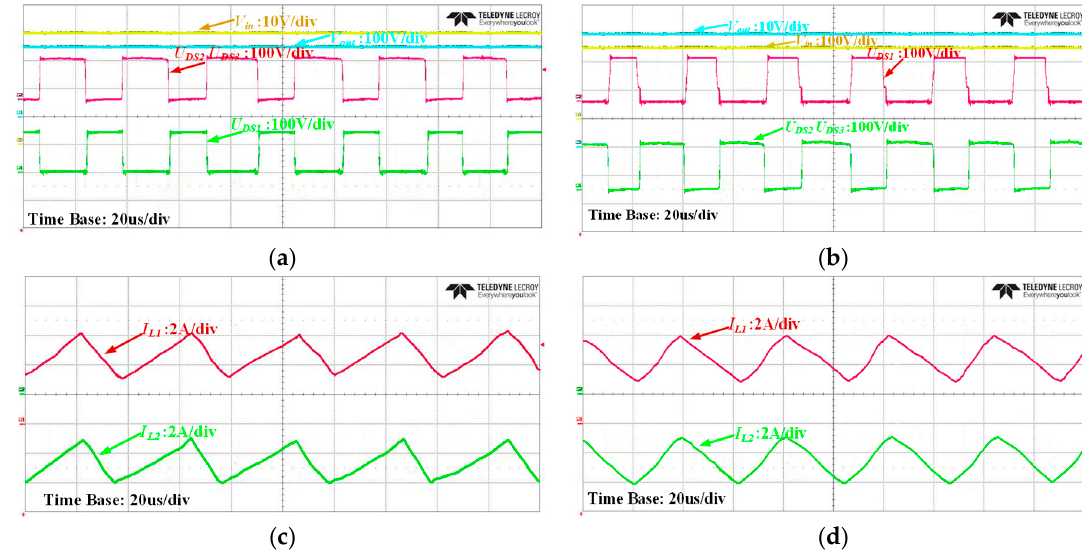
Figure 17. Experimental results: ( a ) voltage stress across Q 1 –Q 3 in boost mode, ( b ) voltage stress across Q 1 –Q3 in buck mode, ( c ) inductor current in boost mode, and ( d ) inductor current in buck mode.